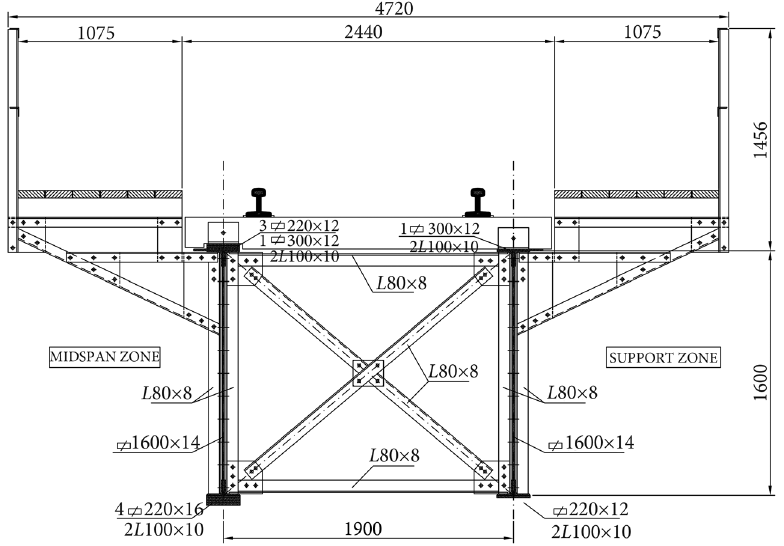
Fig. 4. A cross-sectional view of the railway bridge, units in